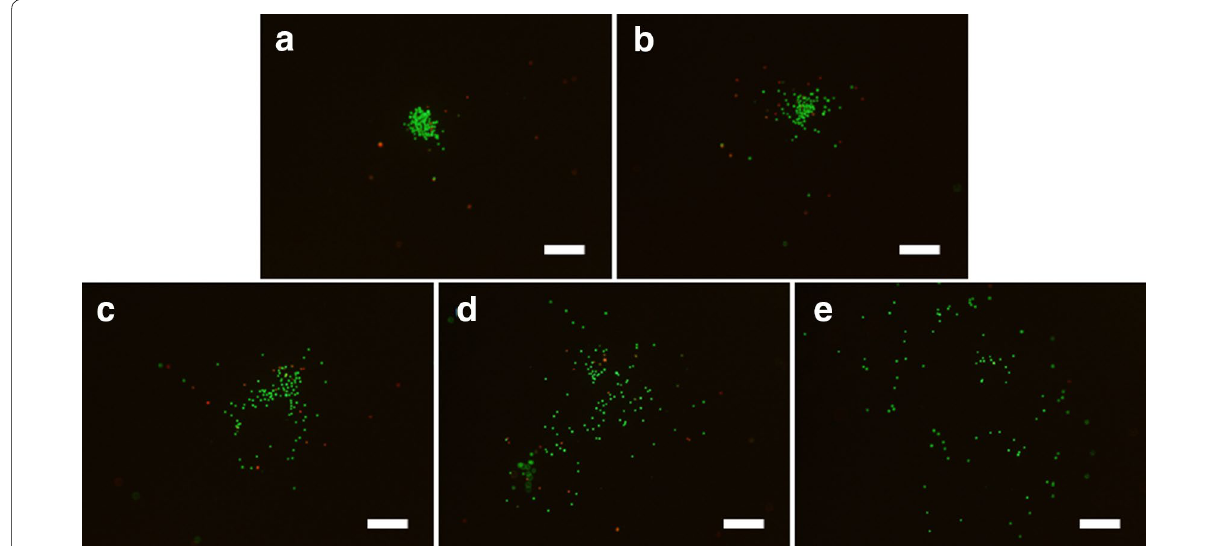
Fig. 4 Live-dead assay of fibroblast cells dispensed onto a collagen gel at positive pressures of a 25 kPa, b 50 kPa, c 75 kPa, d 100 kPa, and e the control (pipetting). All scale bars are 500 μm